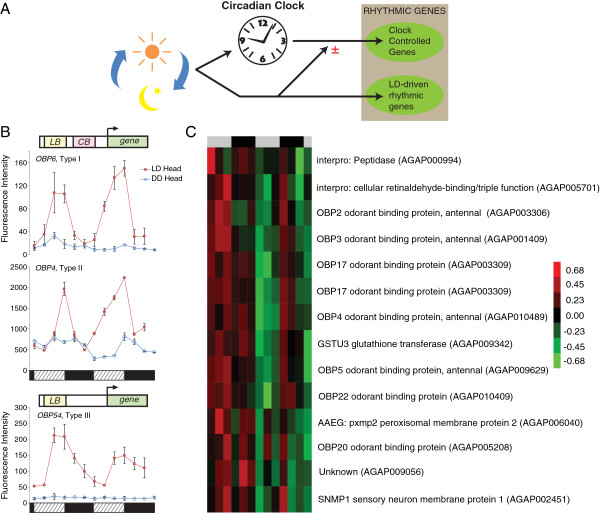
Light regulation of the An. gambiae transcriptome. (A) Model of the regulation of 24 hr rhythmic expression by the endogenous circadian clock and the LD cycle from our studies and other organisms [30,37,48,50,51,69-72]. CCGs are a subset of rhythmic genes with expression driven directly by the circadian clock. Light synchronizes or resets the clock, but activity and rhythms in CCGs persist without LD cycle input. Under LD conditions, additional “LD-driven rhythmic genes” are expressed rhythmically, and a proportion of CCGs have inhibited or enhanced rhythmicity, controlled by both the clock and the direct action of light. (B) Microarray data of OBPs highlights the diversity of mosquito light-regulated expression, with various levels of interaction between clock-and light-driven control. Type I group (e.g. OBP6) are rhythmic under LD and DD conditions, with amplitude of expression higher under LD conditions. Type II group, (e.g. OBP4) have rhythmic expression dampened in DD, but this occurs in the second cycle under constant conditions. Expression in the first cycle does not dampen during subjective day relative to subjective night, as would be expected from LD cycle expression. Type III group (e.g. OBP54) has rhythmic expression under LD conditions but virtually no expression under DD. As LD cycle collection began at ZT12, and DD collection at subjective CT0, ZT16 and 20 data are appended to end of the collection. Day/subjective day and night/subjective night indicated by the horizontal hashed/black bars. Hypothesized regulation via light box (LB) and/or clock box (CB) response elements. (C) Hierarchical clustering of additional genes clustering with and displaying a similar LD to DD cycle phenomenon as OBP4 (type II). Expression values normalized to mean value across the time course of each gene, red indicates higher, green lower expression. Subjective day and night indicated by the horizontal gray/black bars. Data shown from head samples.